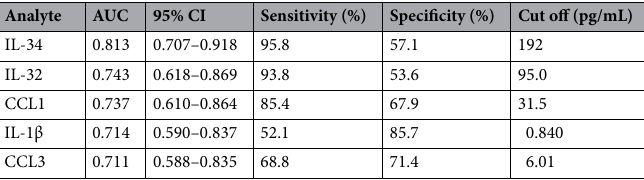
Table 3. Comparison by ROC analysis of significant